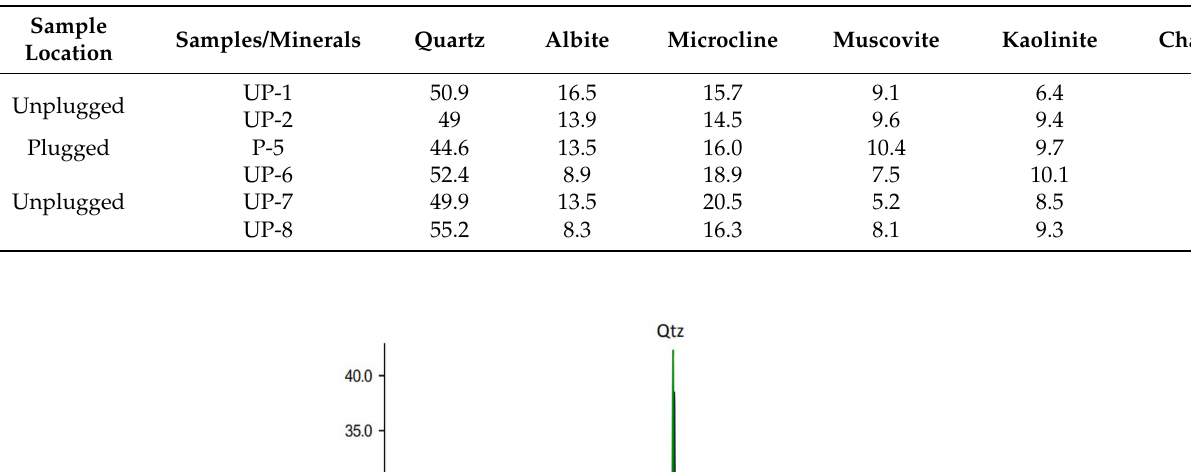
Table 2. Quantitative mineralogical compositions of selected samples, sample titles as in Table 1.